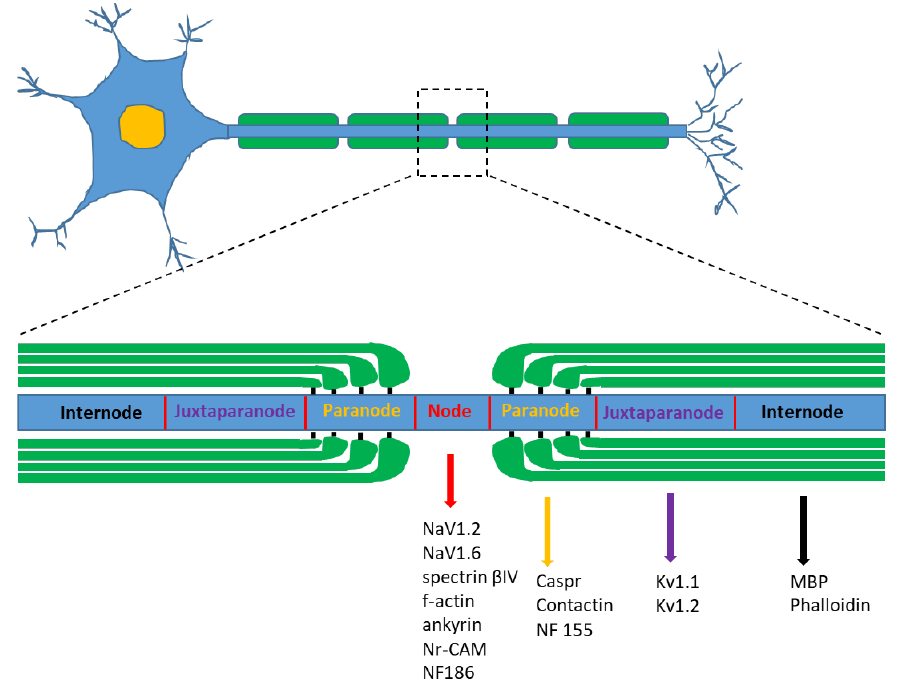
Figure 3. Schematic illustration showing the structure of a myelinated neuron and the different subdivisions of the axonal domain: the node of Ranvier, the paranode, the juxtaparanode and the internode. Each of these domains is characterized by the expression of specific proteins.